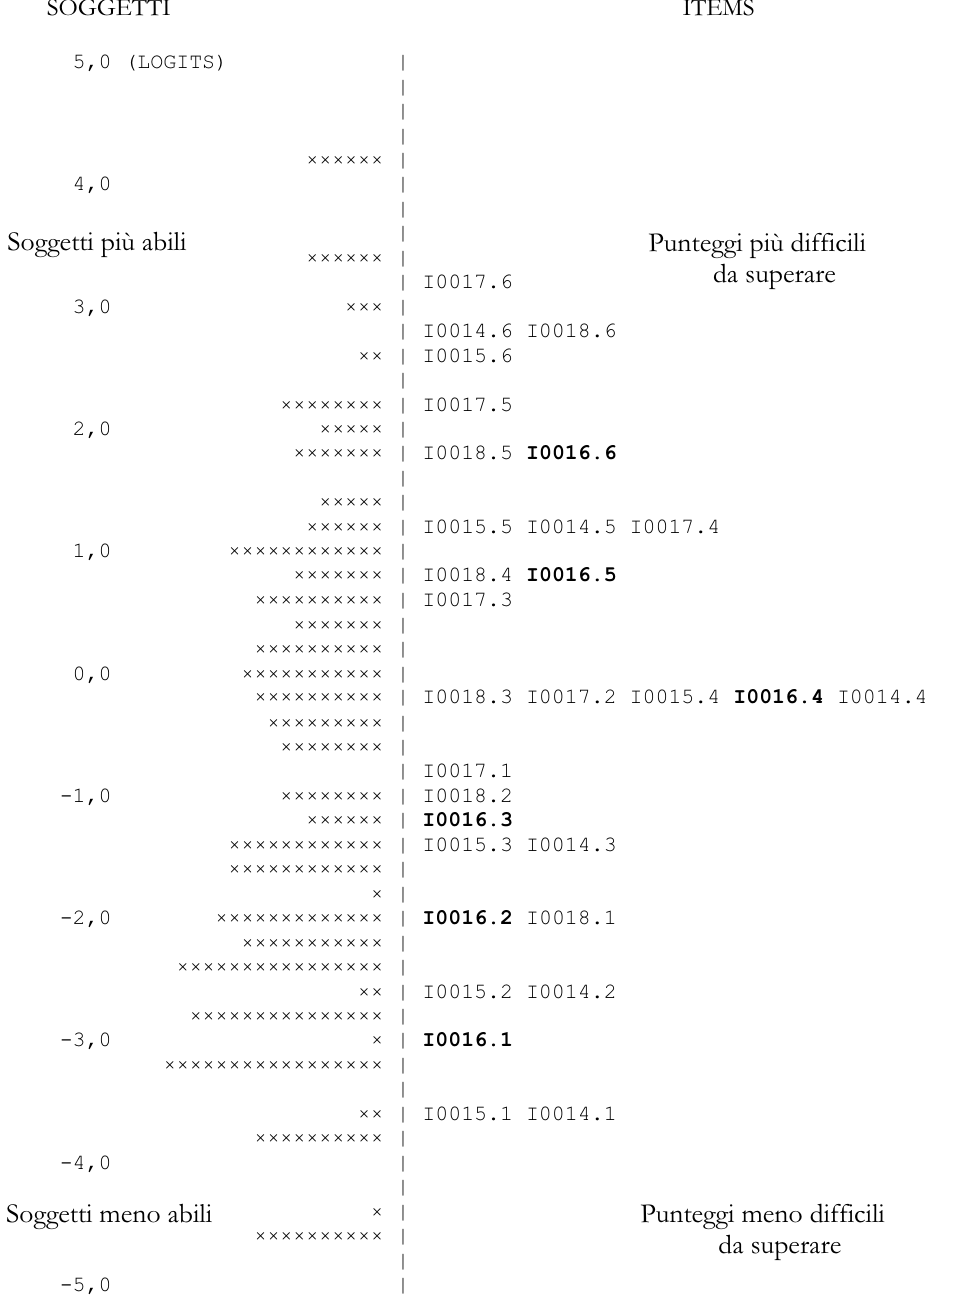
Figura 1 – Mappa item-Subject: al centro viene mostrata l’asse reale in unità logit, a sinistra la distri- buzione a istogrammi (il simbolo x corrisponde a 3 soggetti) delle abilità dei soggetti (nella parte alta i soggetti più abili, cioè più autosufficienti dal punta di vista cognitivo); nella parte destra le stime delle difficoltà delle soglie (il suffisso .1 denota il passaggio dalla risposta 0 a 1, il suffisso .2 dalla categoria 1 a 2 e così via) di ciascun item; in grassetto si evidenzia come esempio la quantificazione delle soglie per l’item